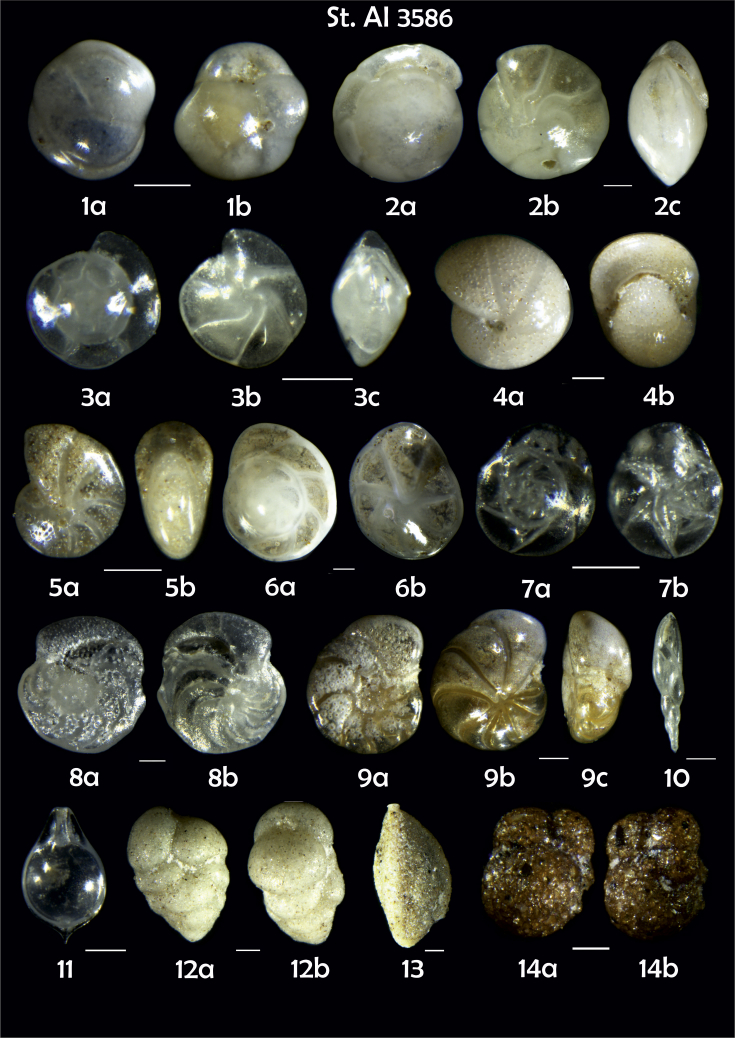
Station 35861Globocaccidulina subglobosa, a lateral view, b apertural view. 2, 3Oridorsalis umbonatus, a spiral view, b umbilical view, c apertural view. 4Melonis pompilioides, a side view, b apertural view. 5M. barleeanus,a side view, b apertural view. 6Hoeglundina elegans, a spiral view, b umbilical view. 7Epistominella exigua, a spiral view, b umbilical view. 8Cibicidoides wuellerstorfi,a umbilical view, b spiral view. 9C. lobatulus, a umbilical view, b spiral view, c apertural view. 10Fursenkoina complanata. 11Fissurina incomposita, 12Karreriella bradyi, a lateral view, b apertural view. 13Sigmoilopsis sp. 14 ?. Scale 100 μm.